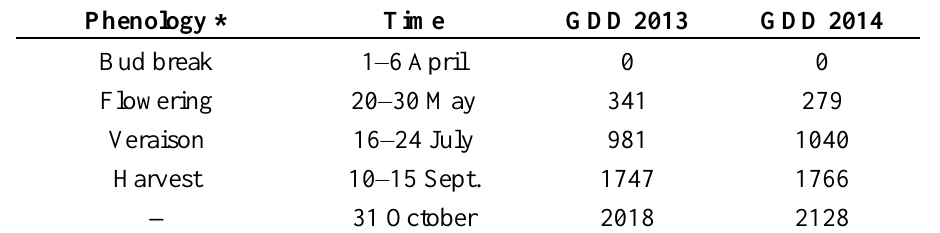
Table 2. Phenological stages and cumulative GDD during the 2013 and 2014 growing